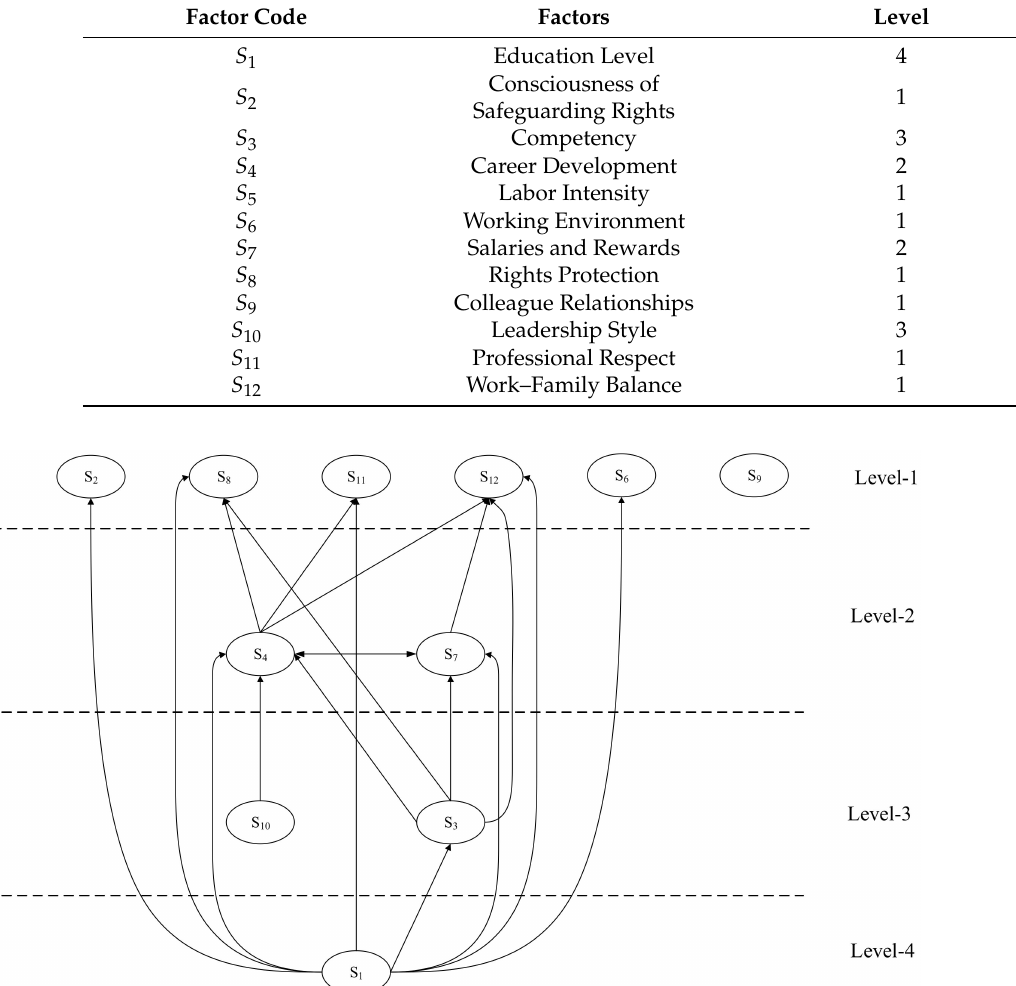
Table 8. Final iteration level partition of factors.